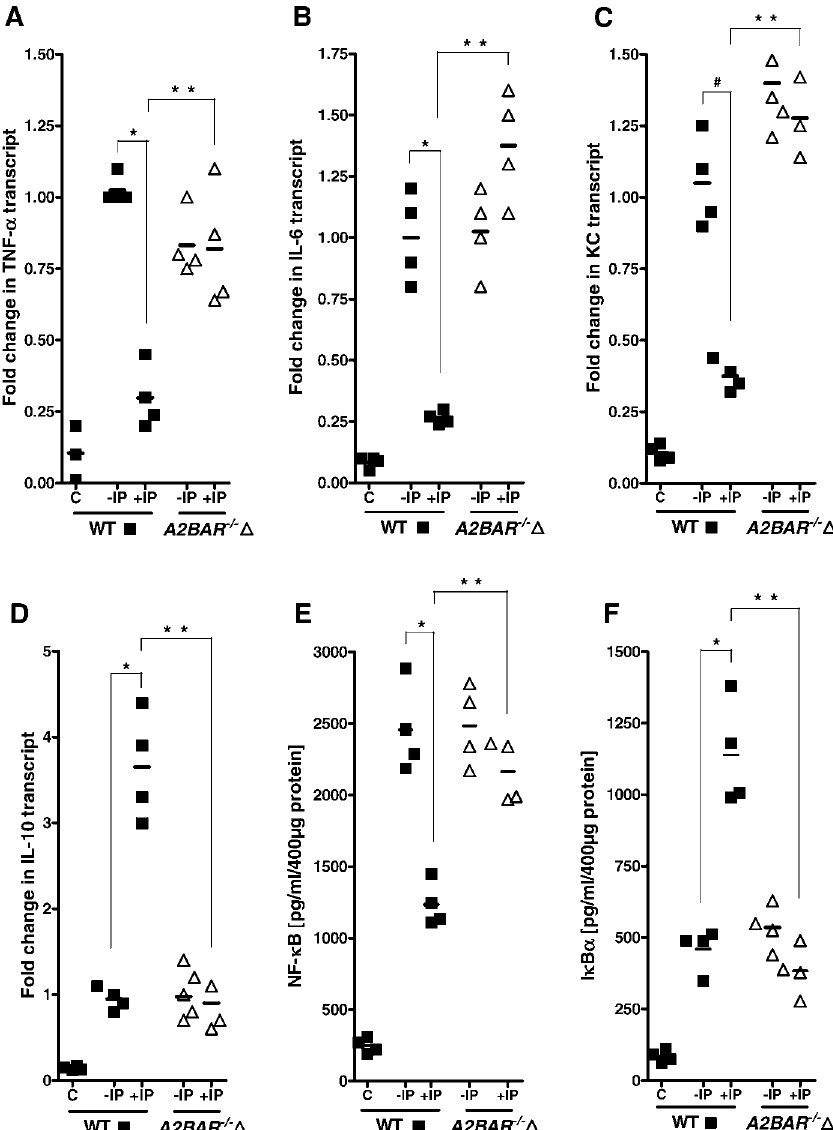
Figure 5. Transcriptional Responses of Inflammatory Cytokines Measured in Renal Tissue A2BAR (cid:2) / (cid:2) mice and their respective age-, weight-, and gender-matched littermate controls (WT) were subjected to right nephrectomy followed by 45 min of left renal artery ischemia with or without prior in situ IP (consisting of four cycles of 4 min ischemia followed by 4 min reperfusion). (A) TNF- a , (B) IL-6, (C) KC (mouse ortholog of human IL-8), and (D) IL-10 were assessed by real-time RT-PCR from renal tissues. Data were calculated relative to b -actin and are expressed as fold change compared to sham-operated animals without IP treatment. (E) NF j B and (F) I j B a levels were evaluated in renal tissue homogenates using a mouse enzyme-linked immunosorbent assay (ELISA). Statistics: One-way ANOVA with Tukey’s post-hoc test was performed (*, p , 0.001 versus WT þ IP; #, p , 0.05 versus WT þ IP; **, p , 0.001 versus the A2BAR (cid:2) / (cid:2) mice with IP). The F -test results are (A) F (4,15) ¼ 39.28, p , 0.001; (B) F (4,15) ¼ 53.40, p , 0.001; (C) F (4,15) ¼ 201.01, p , 0.001; (D) F (4,15) ¼ 61.46, p , 0.001; (E) F (4,15) ¼ 75.76, p , 0.001; and (F) F (4,15) ¼ 56.18, p ,